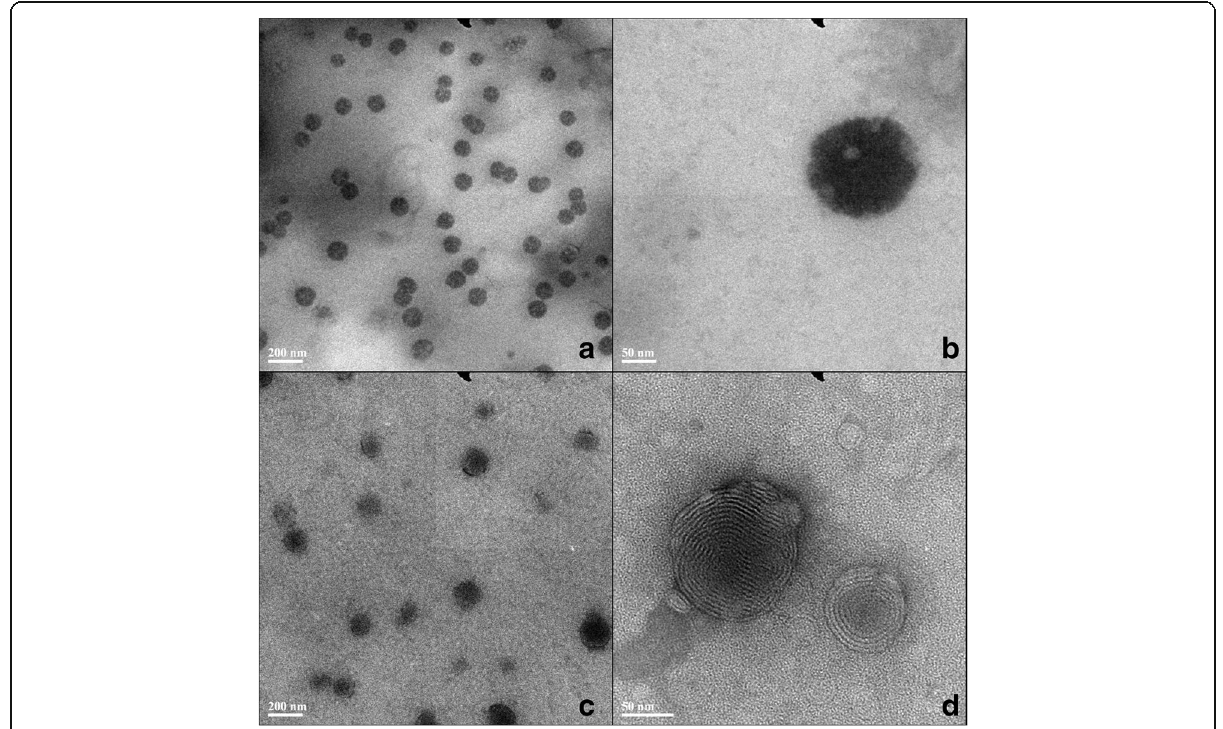
Fig. 1 Transmission electron microscope images of 5-FU ethosomes. Ethosomes of solutions ( a and b ) and ethosomes of gel ( c and d